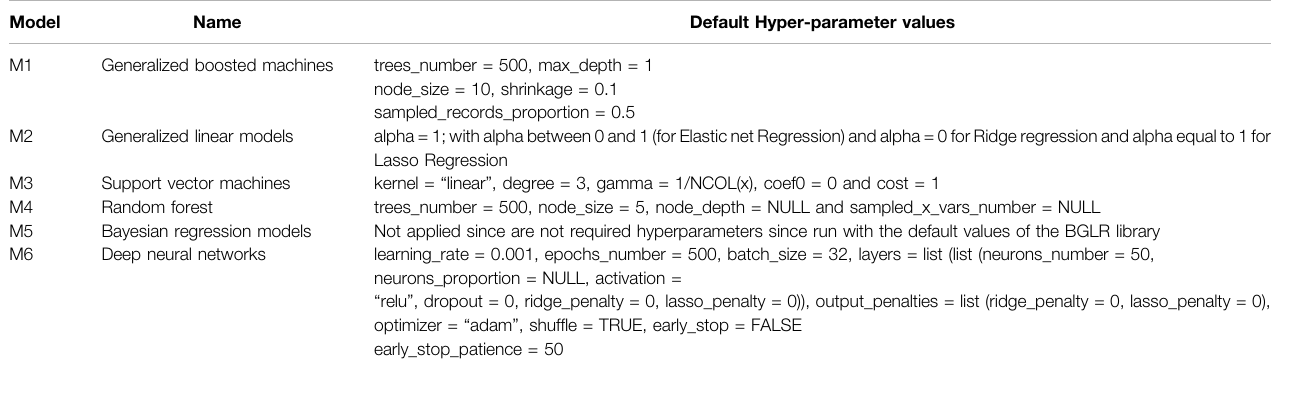
TABLE 4 | Default hyper-parameters for each of the models that can be implemented in the SKM library.